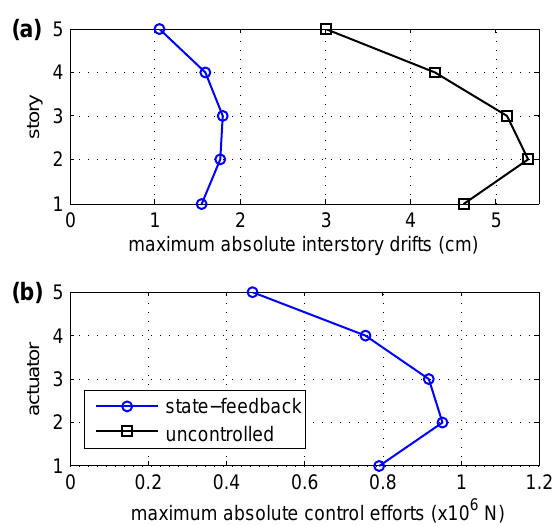
Figure 8: (a) Maximum absolute interstory drifts and (b) maximum absolute control efforts corre- sponding to the uncontrolled building (black line with rectangles) and the optimal state- feedback H ∞ controller (blue line with cir- cles). The full scale North–South El Centro 1940 seismic record has been used as ground acceleration